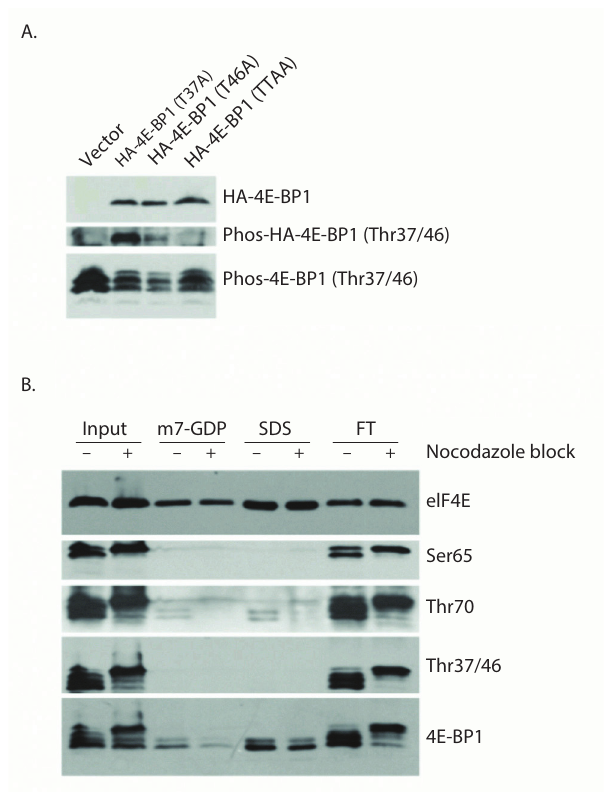
Figure 2. Thr46 phosphorylation is required for Thr37 phosphorylation and is sufficient to prevent eIF4E:4E-BP1 binding. A ) HeLa S3 cells stably expressing 4E-BP1 mutant proteins were subjected to western blotting using anti-HA antibody (upper), and phospho-4E-BP1 (Thr37/46) antibody (middle and lower panels). While phospho-4E-BP1 (Thr37/46) antibodies fail to detect the Thr46Ala single and Thr37/46Ala double point mutant proteins, the Thr37Ala protein is still recognized suggesting that Thr37 is not required for Thr46 phosphorylation. Endogenous 4E-BP1 phosphorylated at Thr37/46 is shown as a control. B ) Untreated and Nocodazole-blocked HeLa S3 cells were subjected to cap-column pull down of eIF4E and associated proteins. eIF4E was eluted with m7-GDP followed by SDS, and fractions were analyzed by western blot using eIF4E and 4E-BP1 antibodies and phospho-4E-BP1 antibodies.